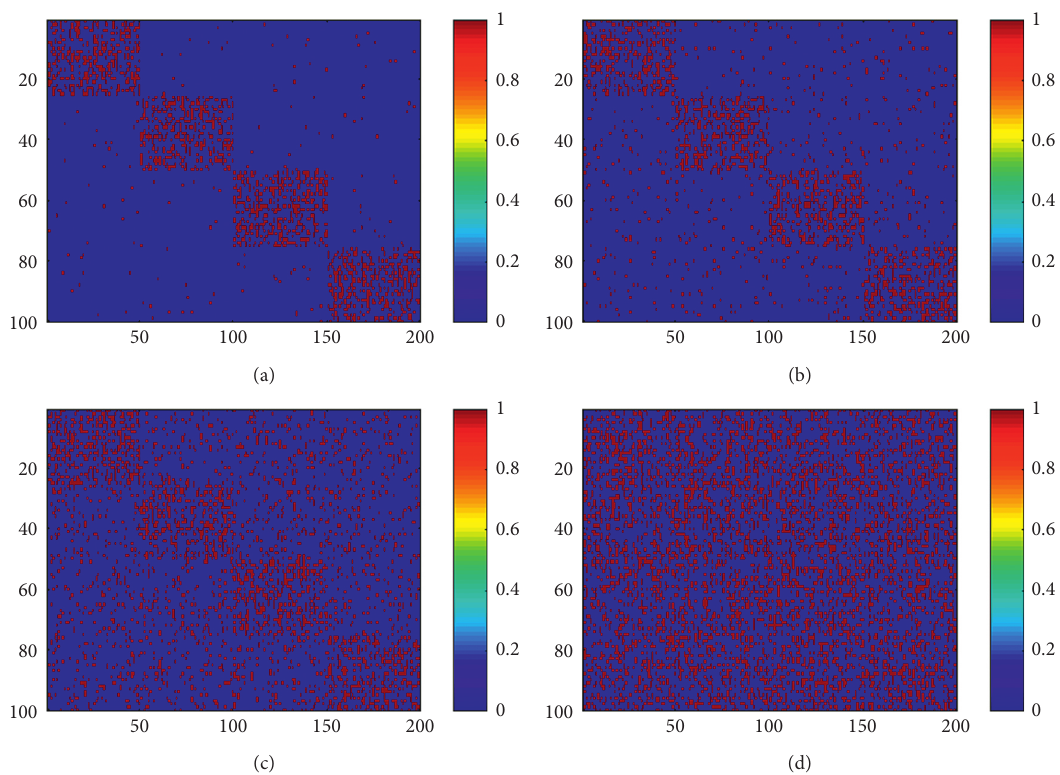
Figure 5: The node attributes’ matrix with different ρ a . (a) ρ a � 0 . 1. (b) ρ a � 0 . 3. (c) ρ a � 0 . 5. (d) ρ a � 0 .